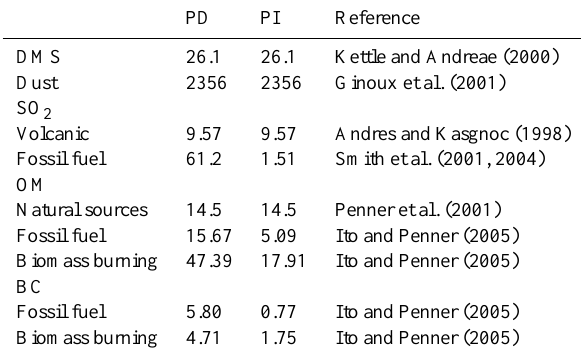
Table 1. Emissions of aerosol and precursors in present day